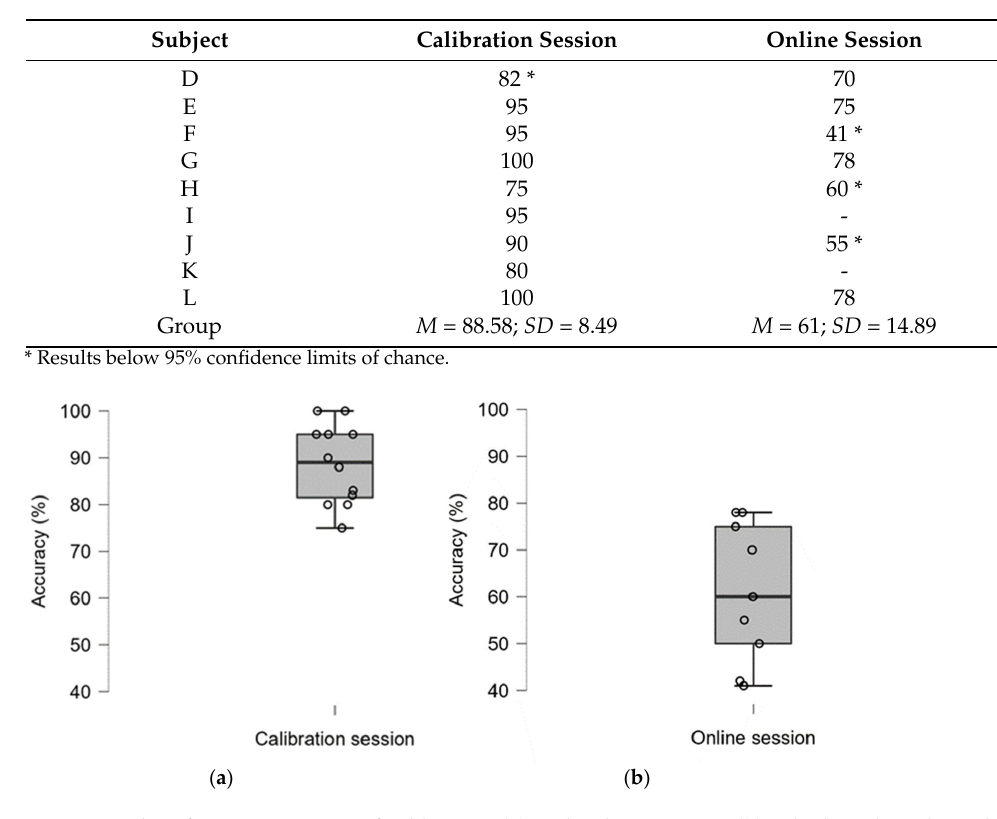
Figure 5. Classification accuracy of calibration ( a ) and online sessions ( b ). The boxplots show the median and interquartile range, whiskers indicate the range.